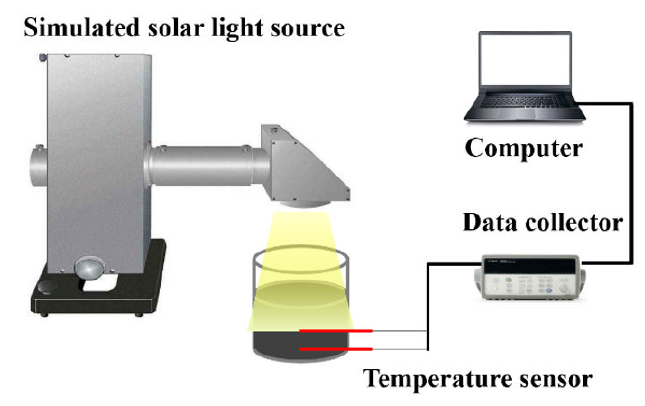
Figure 2. The experimental apparatus for evaluating the photo-thermal conversion